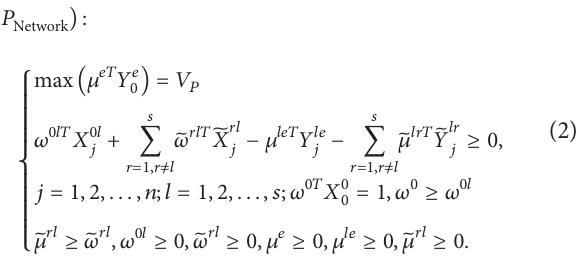
Figure3: Thestructureofnetwork DEA withintermediate products and assignable